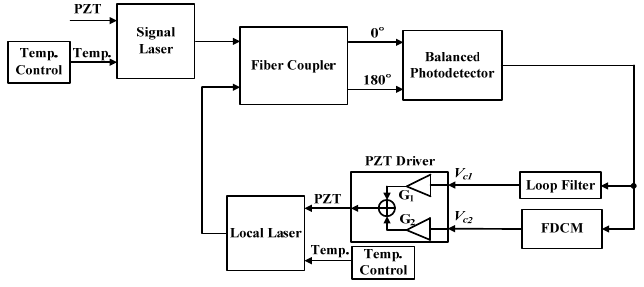
Figure 1. Block diagram of the optical frequency acquisition and the phase ‐ locking loop.